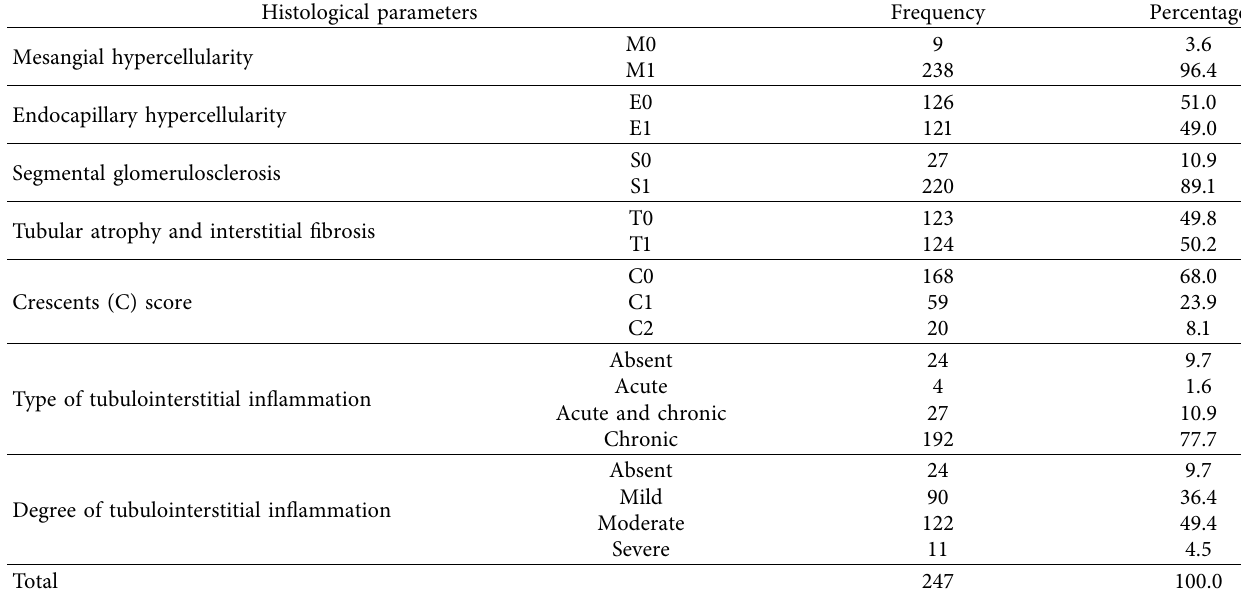
Table 2: Frequency and percentages of histological parameters.